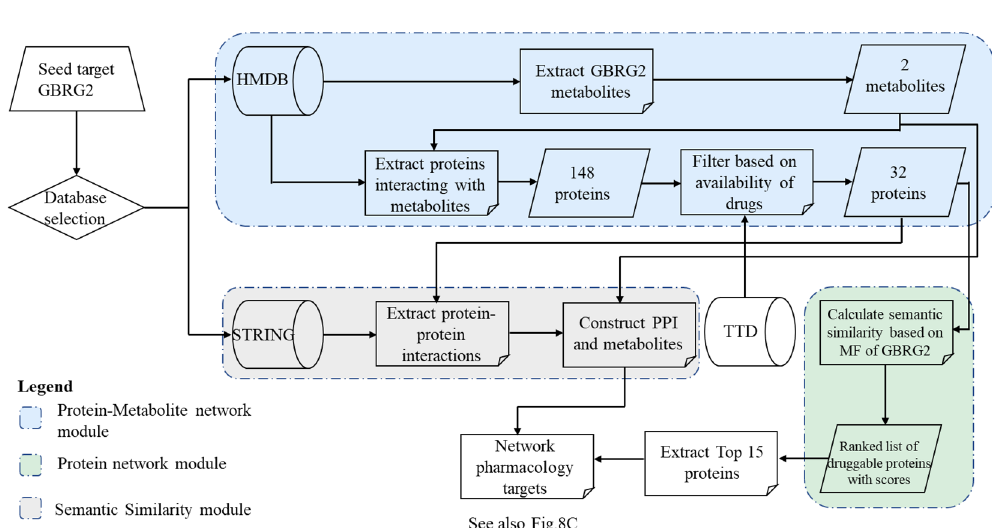
Figure 7. Computational procedure for prioritization of targets through network pharmacology. The pipeline for calculating target prioritization composes of 3 symbiotic blocks. The blue block searches metabolites from the Human Metabolome Database (HMDB) that interact with the GBRG2 protein, collates the metabolites, obtains the targets that interact with them, and screens them against drug availability in the Therapeutic Target Database (TTD). The grey module uses the STRING database to extract PPI from the proteins generated by the blue module and constructs a network from them. The green module uses molecular function (MF) annotations to calculate a GO-based semantic similarity score for the export of the blue module compared to GBRG2, ranking the proteins according to their similarity scores. The output of the green module was used to annotate the top 15 proteins in the